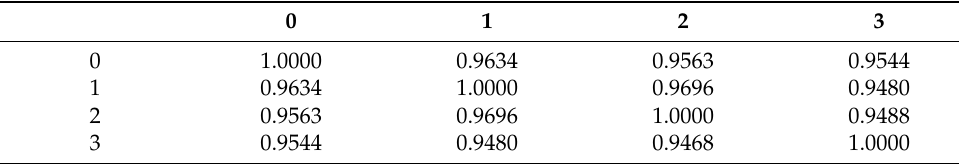
Table 5. Correlational matrix.